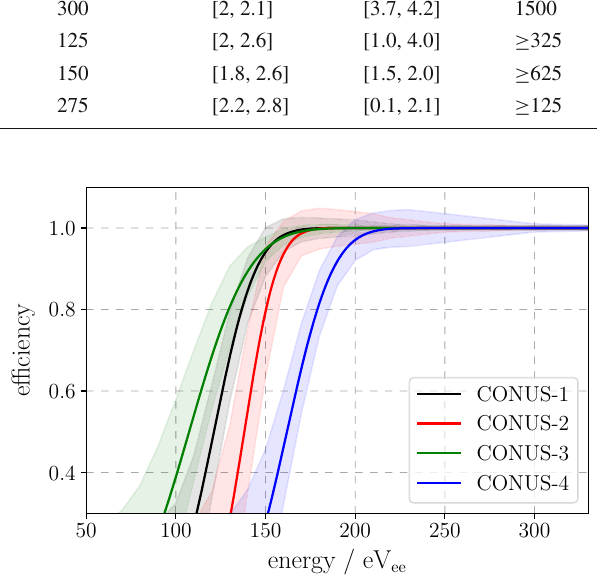
Fig. 12 Trigger efficiency curves of C1–C4, as measured during Run - 2 of the experiment. Below an efficiency of 50%, the curves are less reliable and thus the shown uncertainty bands might be underestimated